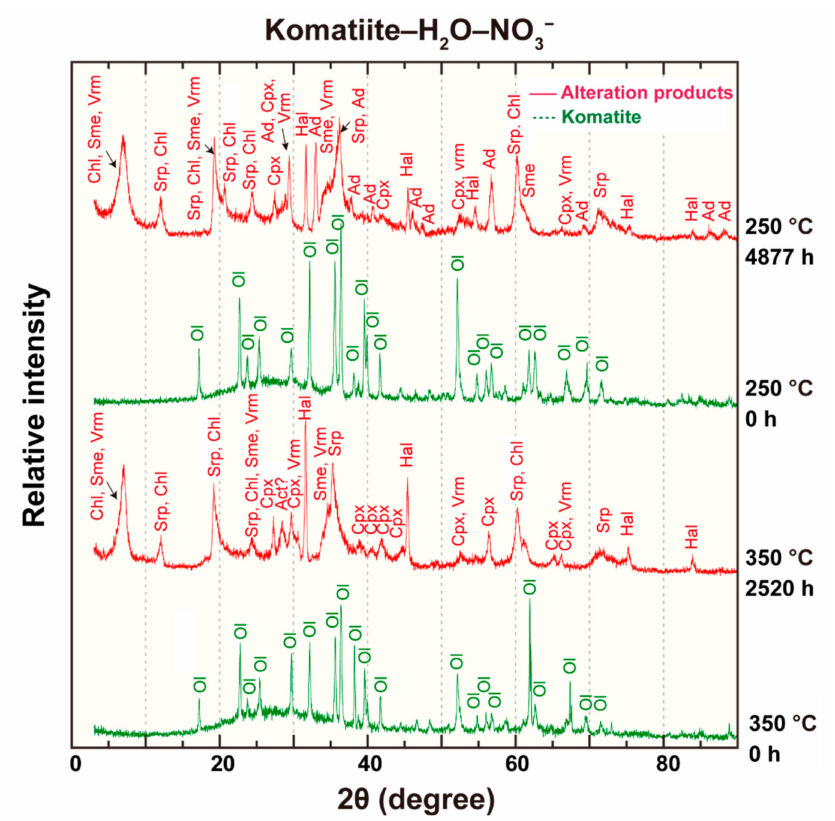
Figure 4. Powder XRD patterns (CuK α ) of the alteration products after experiment N250 (250 ◦ C, 4877 h) and N350 (350 ◦ C, 2520 h), denoted by red. For comparison, XRD patterns (CuK α ) of the synthetic komatiite used in the experiments are presented in green. The mineral identified from the XRD patterns of the synthetic komatiite is ferroan forsterite with a mole (Mg/Fe) ratio of ~9. Abbreviations are the same as in Table